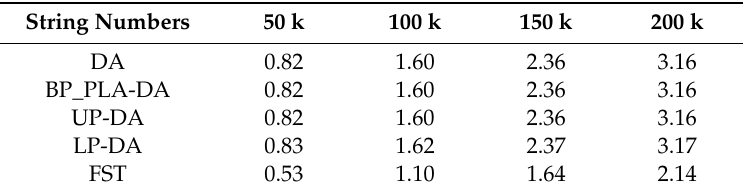
Table 3. DBLP storage spaces (MB).